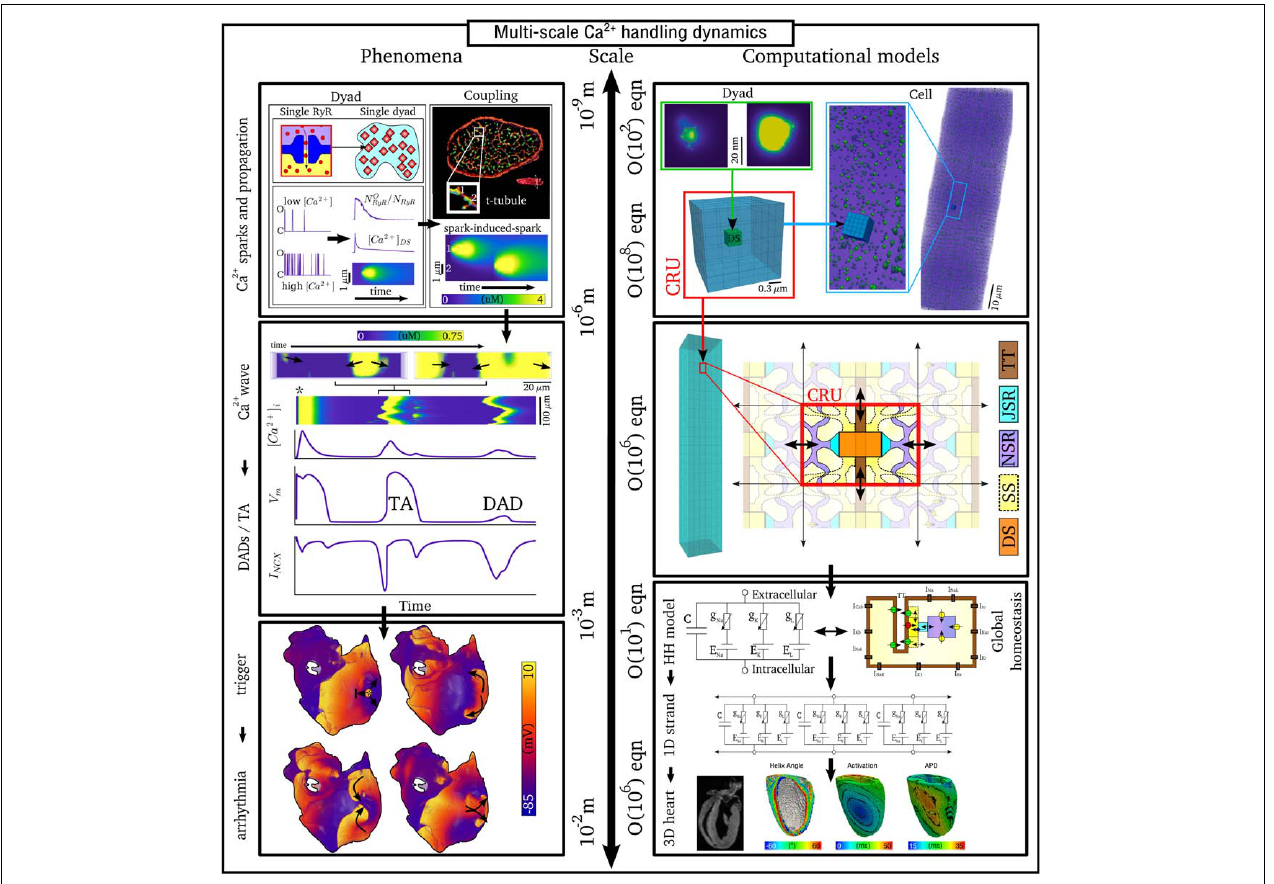
FIGURE 2 | Illustration of the scales involved in cardiac Ca 2 + -handling electrophysiology. Left, upper: illustration of a single RyR and the distribution of RyRs in a dyad, RyR channel function at low and high local Ca 2 + , and propagation of a Ca 2 + -spark between dyads. Cell-structure image re-rendered using data from Jayasinghe et al. (2018a). Left, middle: Illustration of an intracellular Ca 2 + -wave and the impact of the spontaneous Ca 2 + -transient on NCX and the action potential (AP), demonstrating both a delayed-after-depolarization (DAD) and triggered AP (TA). Left, lower: illustration of a focal excitation in tissue which degenerates into a re-entrant excitation pattern. Simulation data from Colman et al. (2013). Right, upper: spatial model of a single dyad (model as presented in Sheard et al., 2019) and illustration of a sub-micron full-cell model with dyads distributed therein. Right, middle: illustration of a coarse-grained 3D cell model with different intracellular and SR compartments labeled. Right, lower: illustration of standard, non-spatial Hodgkin-Huxley electric circuit models of cardiac electrophysiology, their coupling in a 1D strand, and implementation in 3D whole-heart models based on imaging data, reproduced using data from Benson et al.